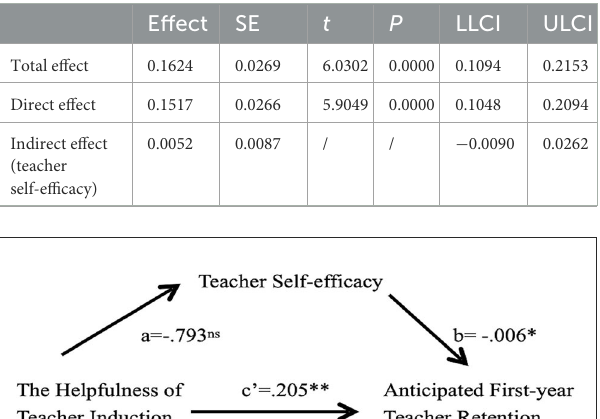
TABLE 3 Mediation test.